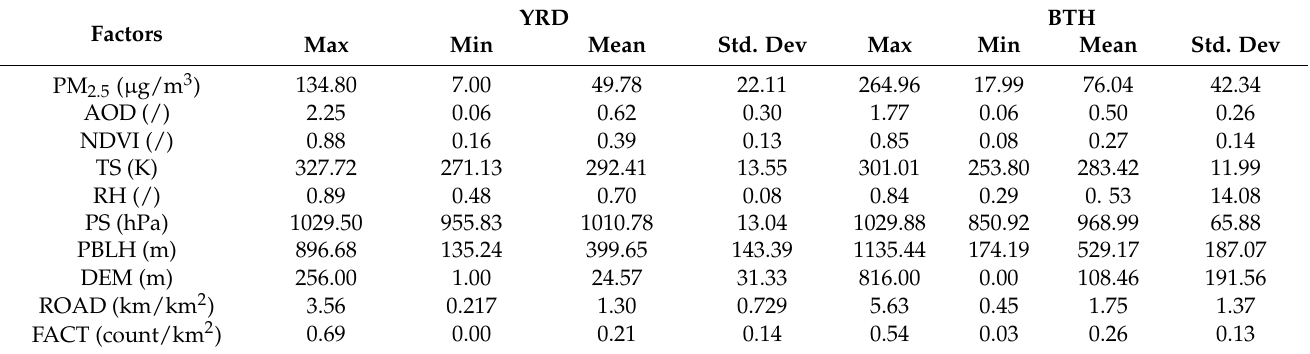
Table 2. Summary statistics of PM 2.5 concentrations and all variables in the YRD and BTH regions (Std. Dev: Standard Deviation).